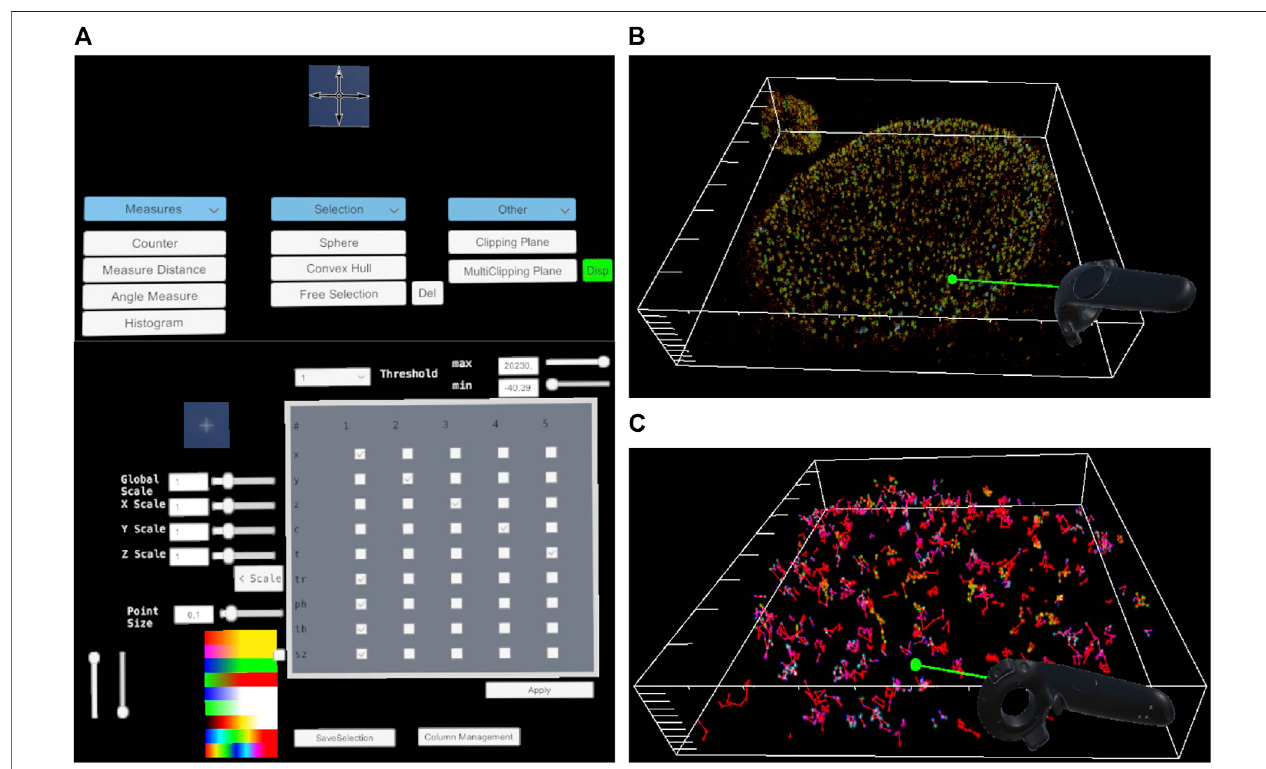
FIGURE 1 | General overview of Genuage. The VR interface (A) allows the adjustment of the visual parameters associated with the point cloud. It includes associating visual parameters to speci fi c columns in the data, adjusting the color code, scaling, and aspect ratio. A set of analysis tools allow performing VR-assisted measurementsandcomplicated3Dselections.ClippingplanetoolsallowustoexploretheinnerlayersofthepointcloudinVRatarbitraryangles.Multidimensionalpoint cloud data generated by single-molecule localization microscopy are explored in VR in 3D (B) and (3D + time) (C)